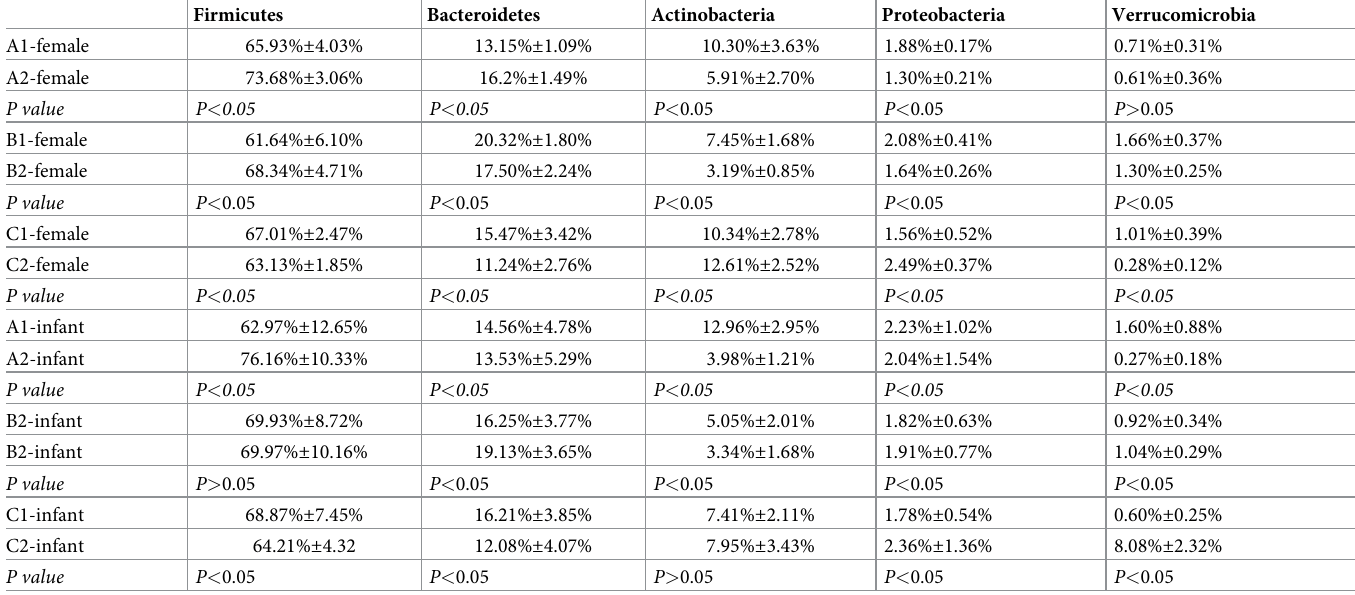
Table 1. Differences in the five most abundant phyla of intestinal microbiota in female and infant FMD at different separation times (A: 80 days, B: 90 days, C: 100 days) as well as before (1) and after (2) separation.